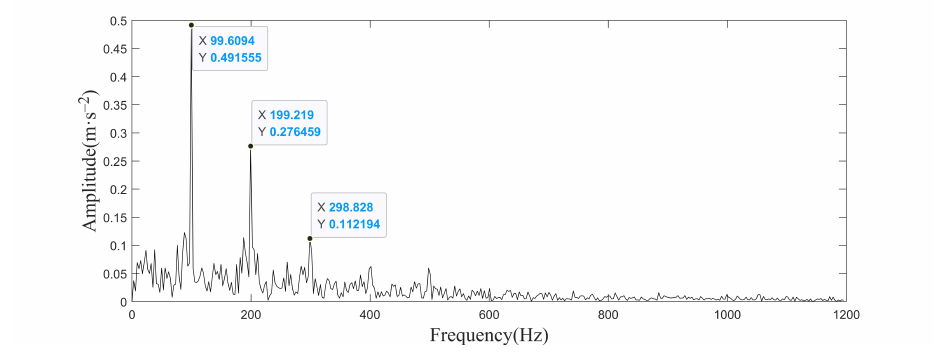
Figure 8. Envelope spectrum of signal x (cid:48) ( t )